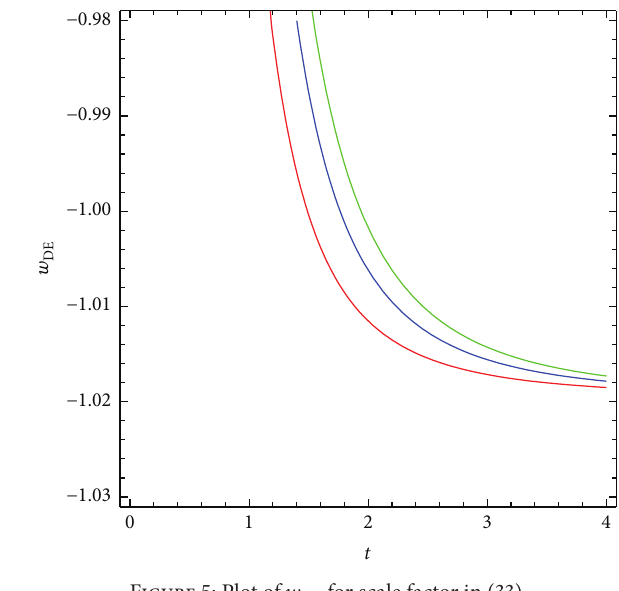
Figure 5: Plot of 𝑤 DE for scale factor in (33).